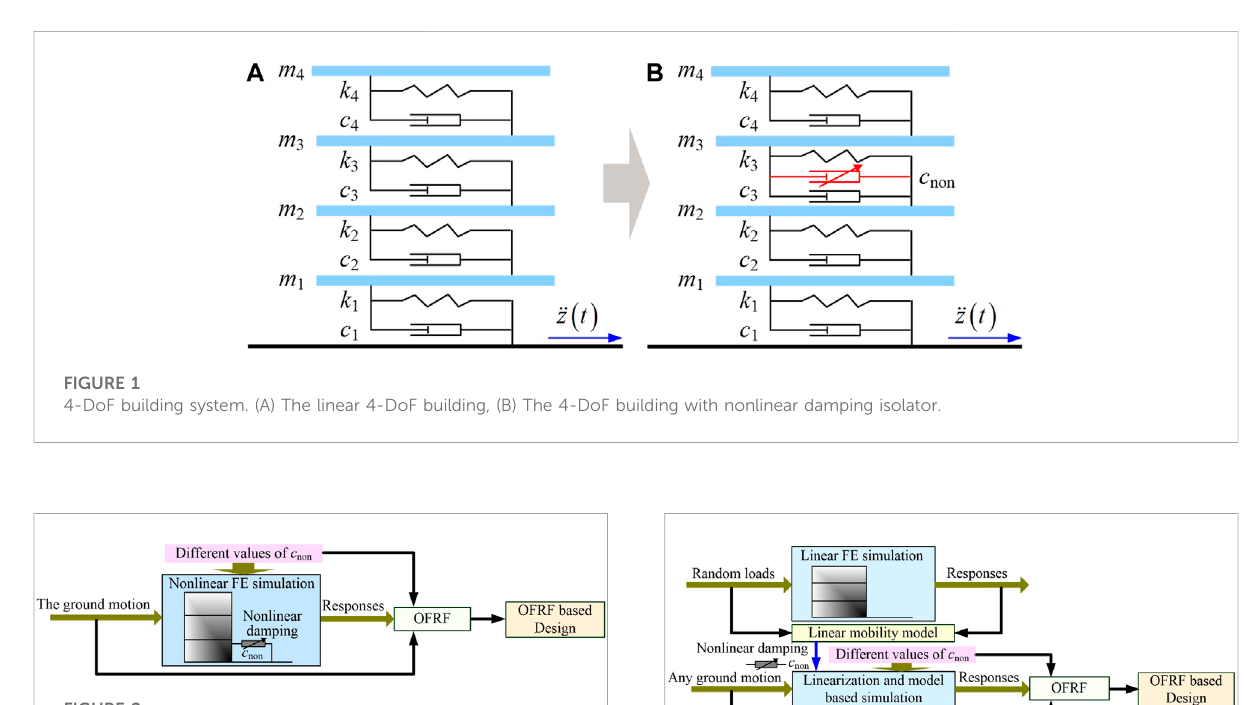
FIGURE 2 Traditional design of nonlinear damped building isolation system. FIGURE 3